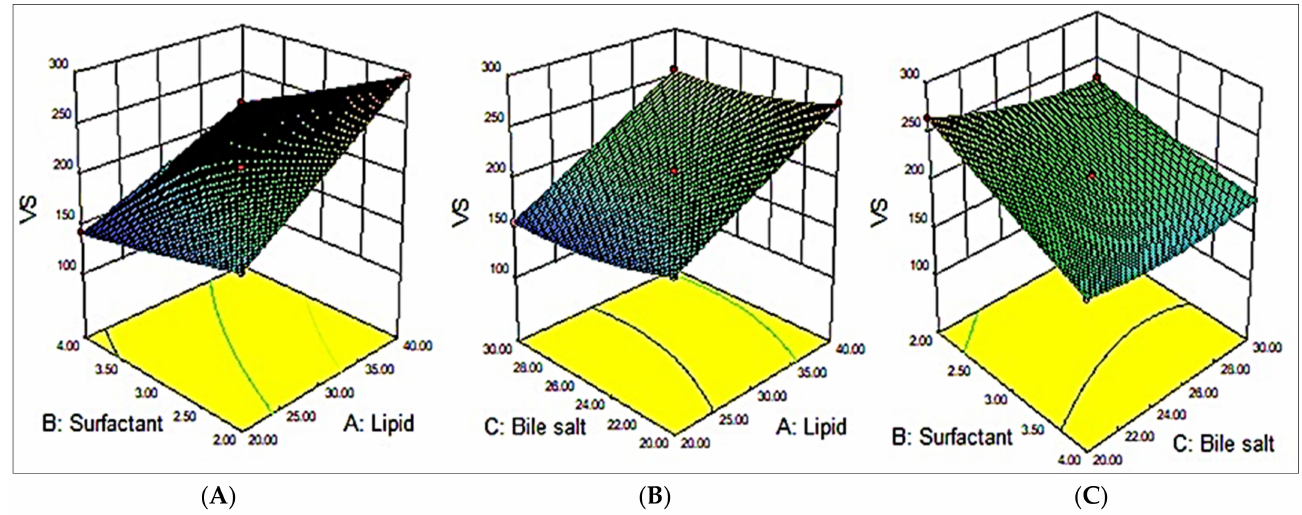
Figure 1. Effects of variables, namely, cholesterol ( A ), surfactant ( B ), and bile salt ( C ), on the depen- dent variable vesicle size (VS; Y 1